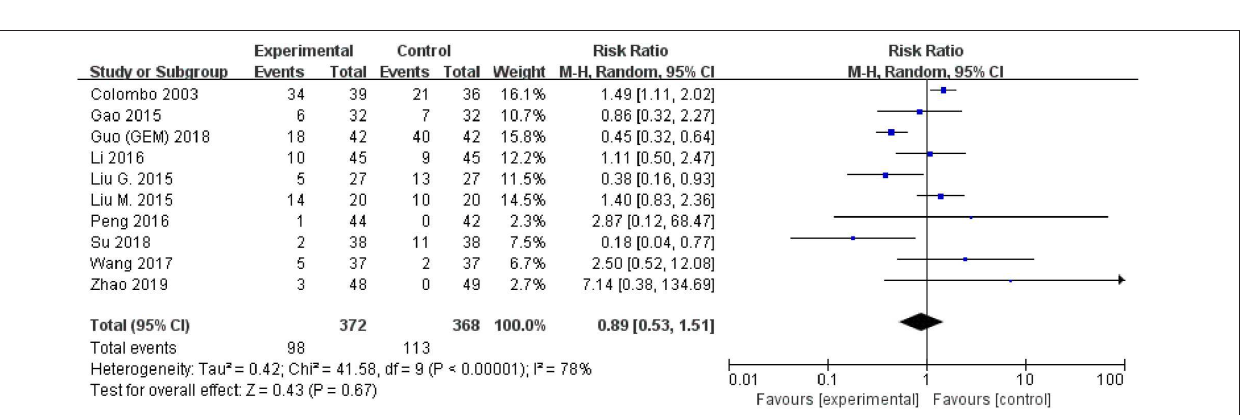
FIGURE 7 | Forest plot of adverse event rate comparing thermal intravesical chemotherapy with normal temperature intravesical chemotherapy.